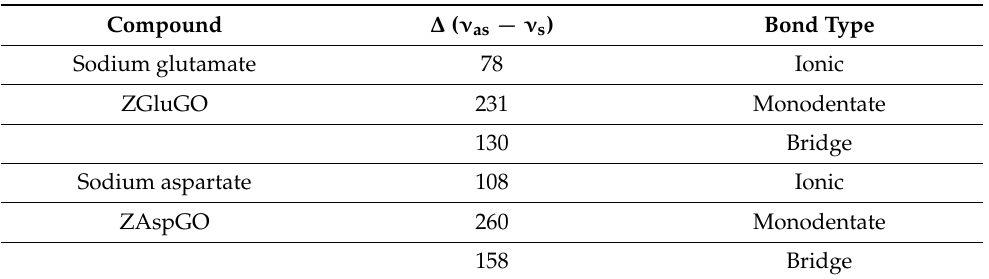
Table 1. Relationships between the asymmetric and symmetric vibrational modes of ZGluGO and ZAspGO. Compound ∆ ( ν as − ν s ) Bond Type Sodium glutamate 78 Ionic ZGluGO 231 Monodentate 130 Bridge Sodium aspartate 108 Ionic ZAspGO 260 Monodentate 158 Bridge